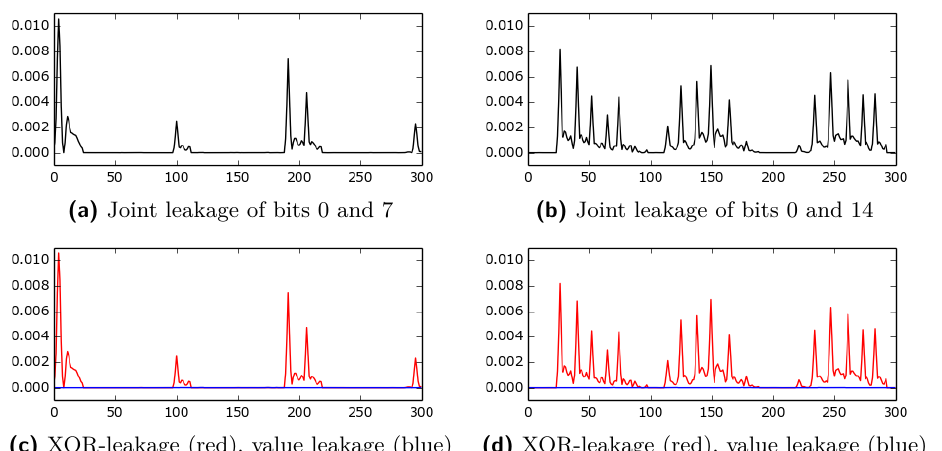
Figure 13: SNR (y-axis) for the transition between key bits 0 and 7 on the left, and 0 and 14 on the right over 300 POIs (x-axis). The joint leakage is entirely caused by XOR transitions (red) while no value leakage (blue) is